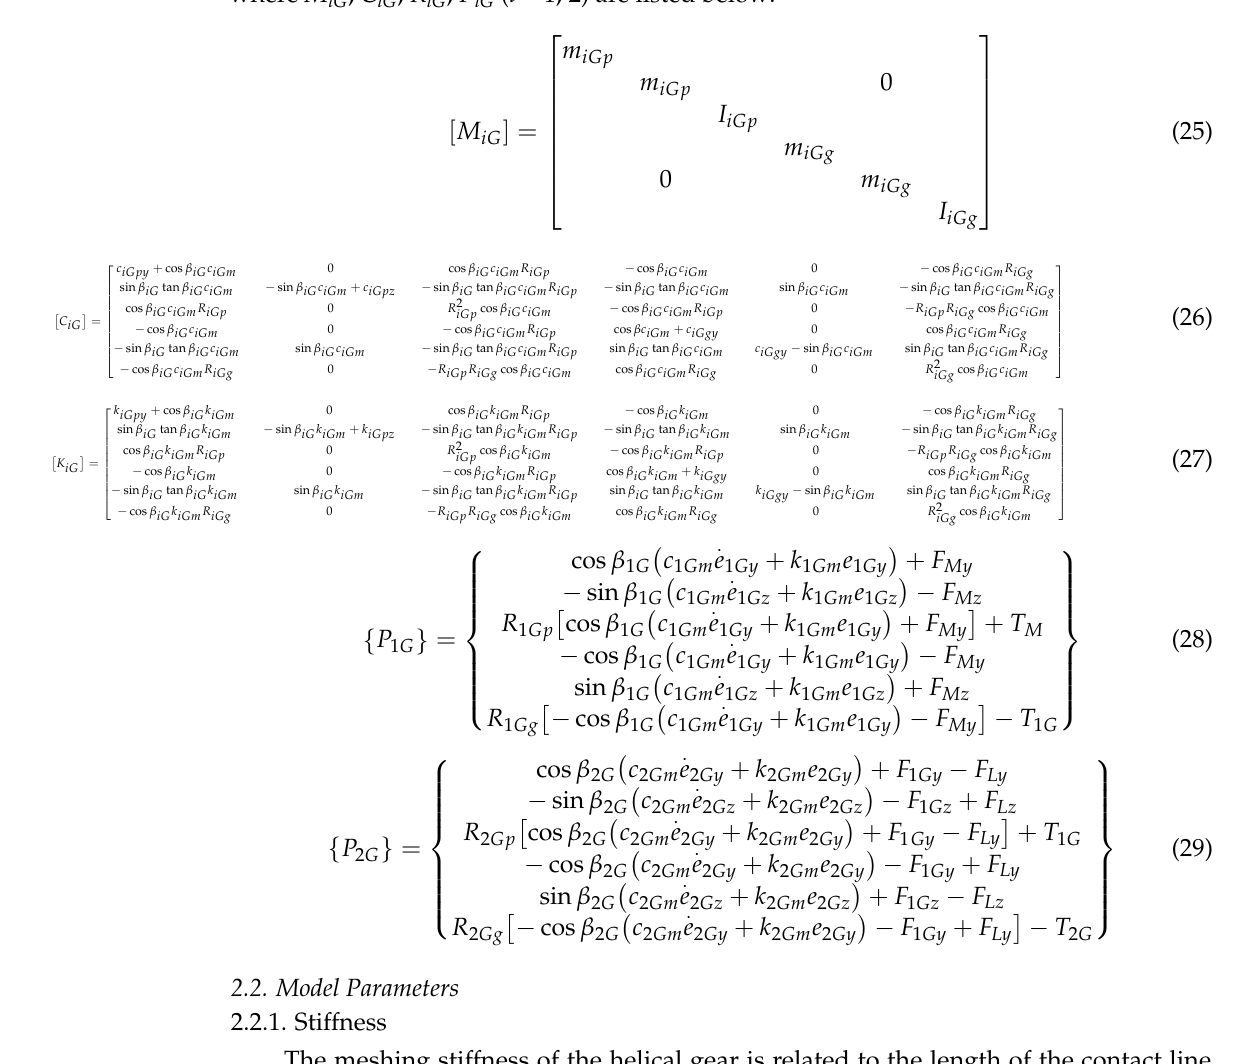
α ≤ ε β ; ( b ) ε α > ε β